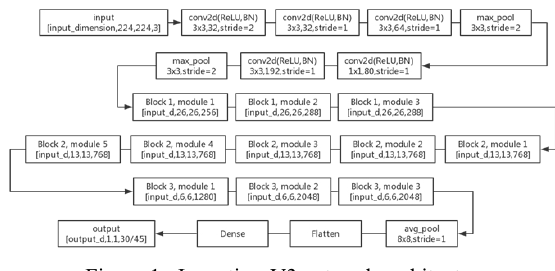
Figure 1. Inception-V3 network